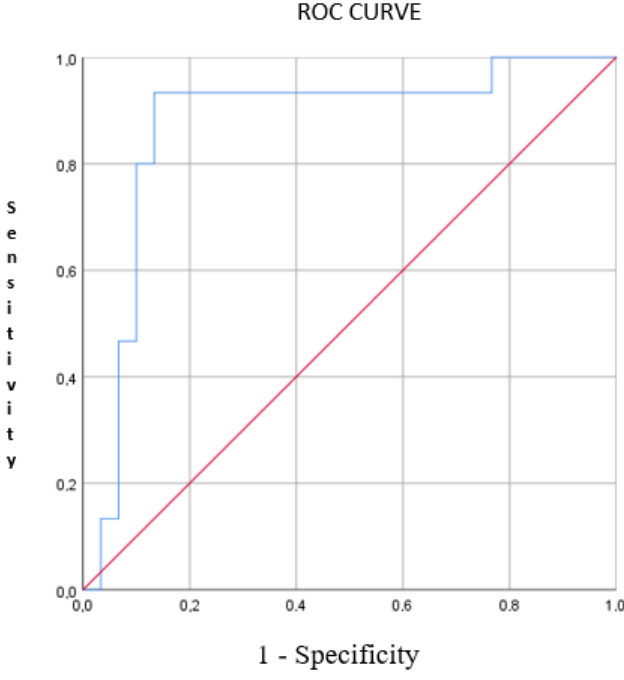
Figure 3. Two-dimensional PCA with 2 composite factors (x axis = Principal Component 3; y axis = Principal Component 1) showing the discrimination between patients with HNC (blue circles), allergic rhinitis (red squares) and healthy controls (green triangles). Cross-validated accuracy was 75.3% ( p < 0.01).